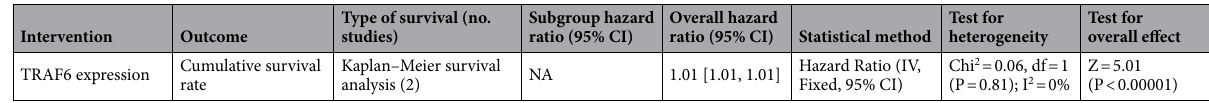
Test for overall effect